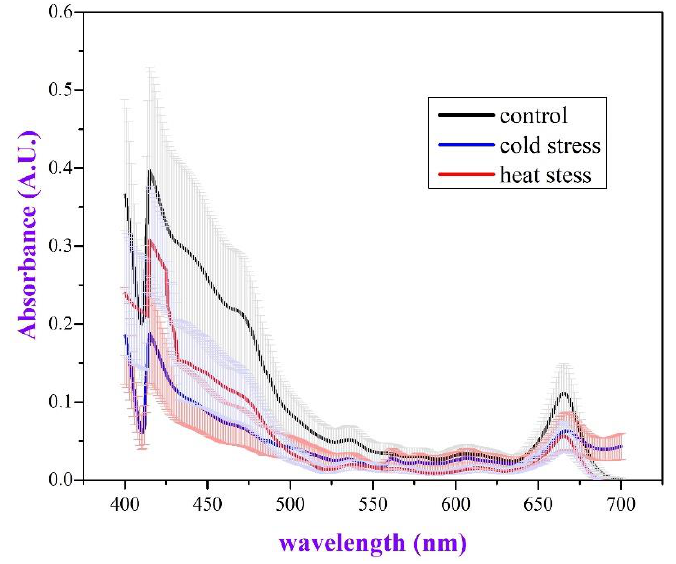
Figure 4. The absorbance spectra of the leaf pigments for all three groups of plants. Error bars represent the standard error of the mean (SEM, N = 4, n = 1).